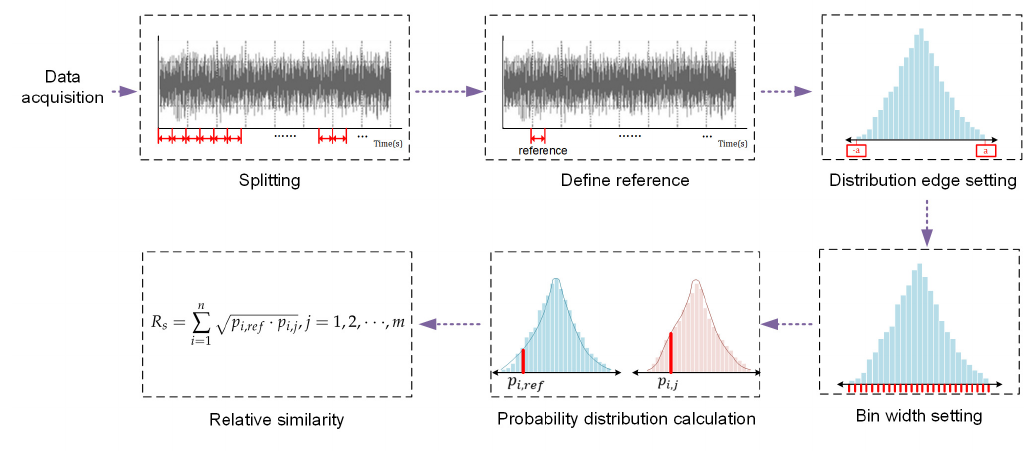
Figure 4. Framework of calculating AE discrete probability distribution relative